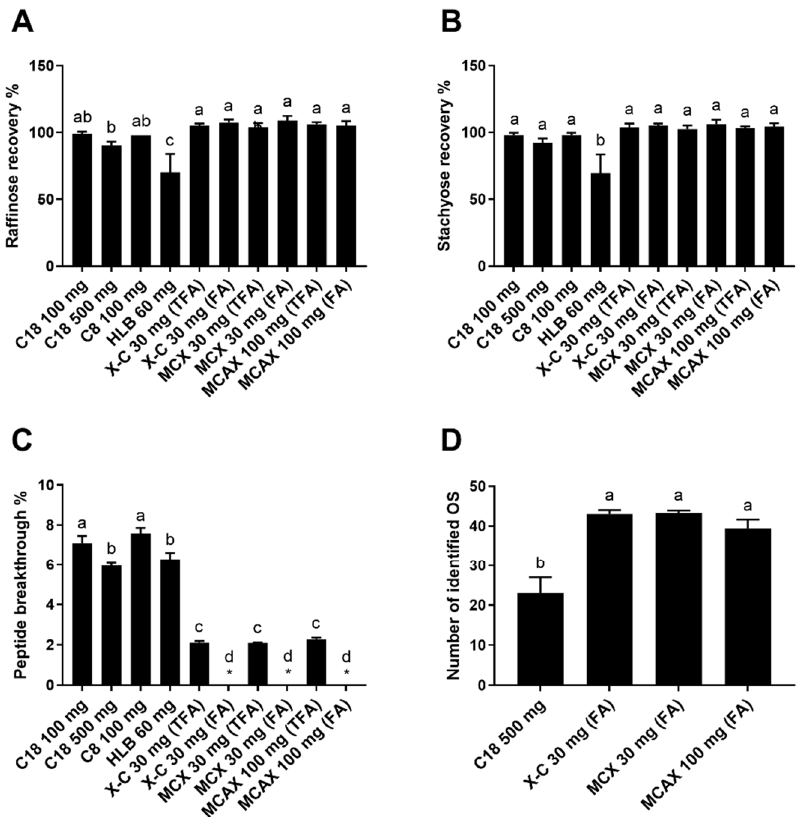
Figure 1. Recovery of raffinose ( A ) and stachyose ( B ), breakthrough of peptides ( C ), and number of oligosaccharides (OS) identified with MS/MS confirmation ( D ) of the aqueous fractions collected from different SPEs loaded with the proteolyzed almond extract. The asterisks indicate cases where the peptide breakthrough was lower than the detection limit (0.8%). Reverse-phase SPE (C18 100 mg, C18 500 mg, C8 100 mg, and HLB 60 mg) was conducted using TFA as a modifier. Mixed-mode SPE cartridges (X-C 30 mg, MCX 30 mg, and MCAX 30 mg) were eluted with either 0.1% TFA in water or 0.1% formic acid (FA) in water. Data are presented as mean ± standard deviation ( n = 3). Different lowercase letters represent a significant difference at p < 0.05.